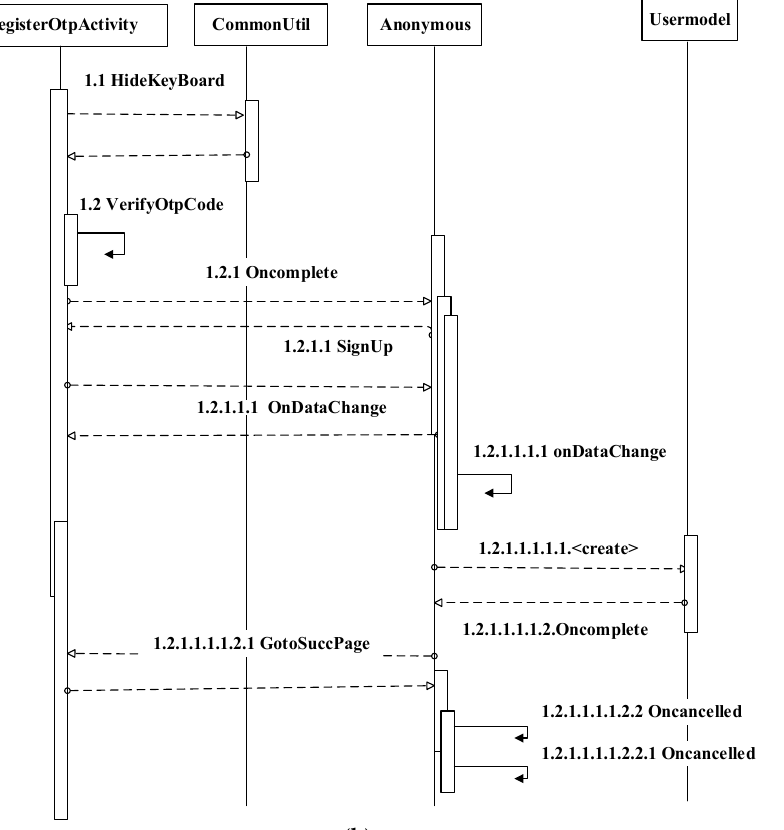
Figure 6. ( a ): Register activity of proposed method and ( b ): Register OTP activity of proposed